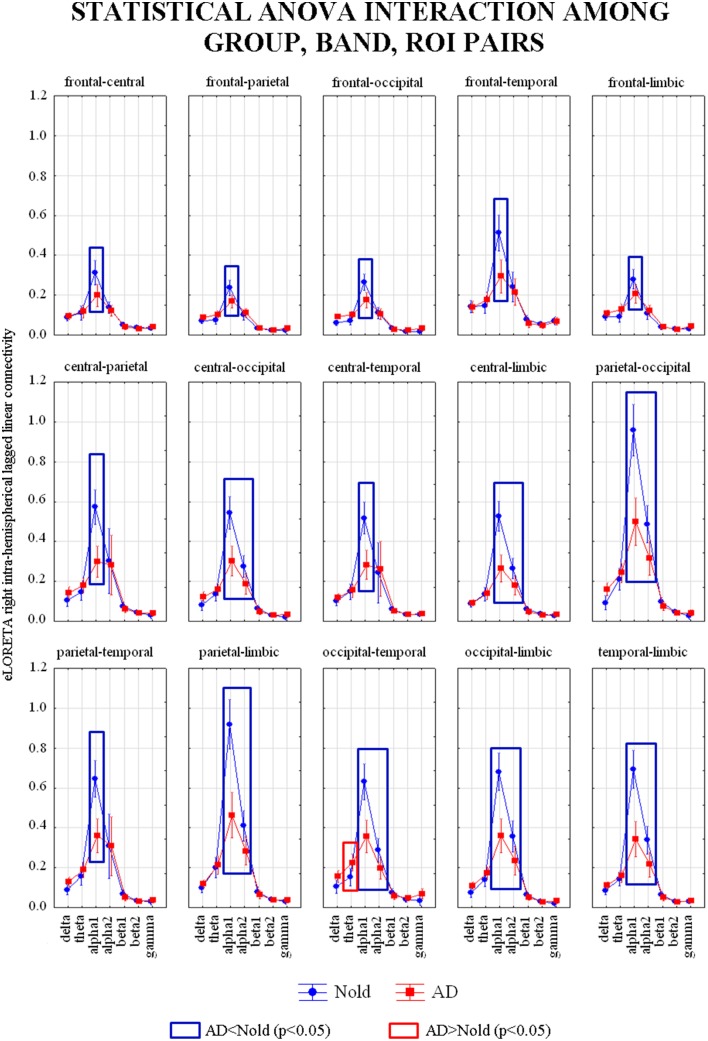
Diagram showing the grand average of the EEG intra-hemispherical lagged linear connectivity computed between each pair of regions of interest (ROI) in the right hemisphere. These values refer a statistically significant ANOVA interaction [F(84, 18312) = 4.6296, p < 0.0001] among the factors Group (AD, Nold), ROI pairs (frontal-central, frontal-parietal, frontal-occipital, frontal-temporal, frontal-limbic, central-parietal, central-occipital, central-temporal, central-limbic, parietal-occipital, parietal-temporal, parietal-limbic, occipital-temporal, occipital-limbic, and temporal-limbic), and Band (delta, theta, alpha 1, alpha 2, beta 1, beta 2, gamma). Subjects' age, education, IAF, and gender were used as covariates. Legend: the rectangles indicate the ROI pairs and frequency bands in which connectivity values presented the pattern Nold ≠ AD (Duncan test, p < 0.05).